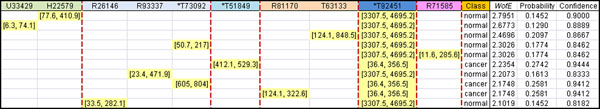
Top 10 rules colon cancer data set Different gene groups are filled in different colors and are separated by dashed lines. LHS of each rule is the gene expression intervals and the RHS is the class. WofE is the weight of evidence measure. The gene marked with "*" indicates it is the mode of the gene group.